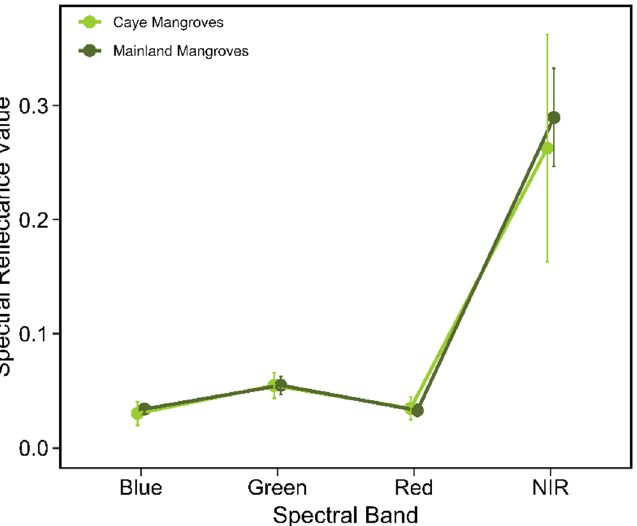
Figure 3. Spectral reflectance curves for mangroves on the mainland and mangroves on the cayes. Error bars represent 1 standard deviation from the mean.